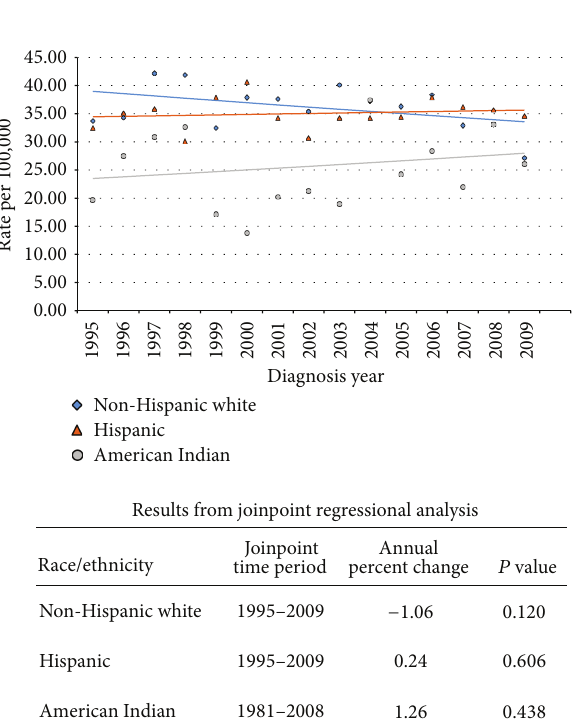
Figure 1: New Mexico colorectal cancer male incidence joinpoint by race/ethnicity, 1995–2009. Figure 2: New Mexico colorectal cancer female incidence joinpoint by race/ethnicity, 1995–2009.